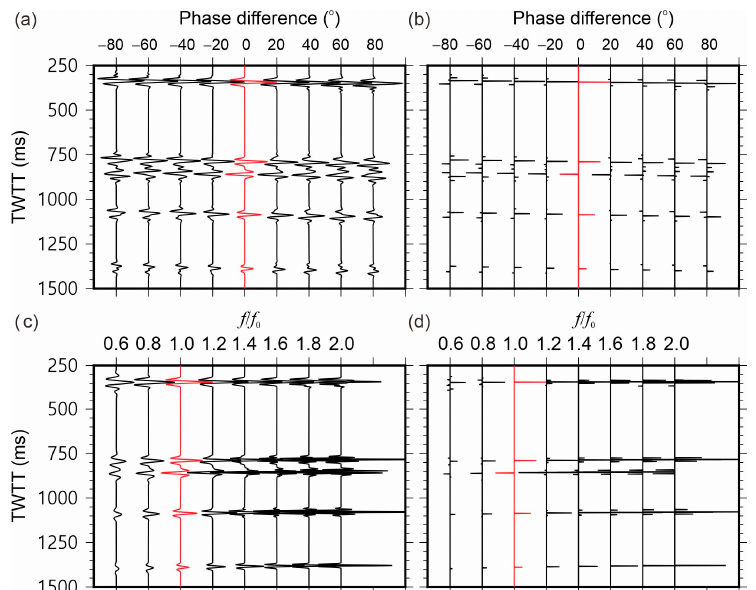
Figure 7. ITD results with N = 20 of iterations by using variable source wavelets (black lines): ( a ) ITD compensation results with inaccurate wavelet phases and ( b ) the associated reflectivity model; ( c ) ITD compensation results with inaccurate dominant frequency and ( d ) the associated reflectivity model. Trace labels show the phase rotations (plots a) and ( b )) dominant-frequency variations (plots c) ( d )) applied to source wavelets. Red lines show the results for an unperturbed wavelet.